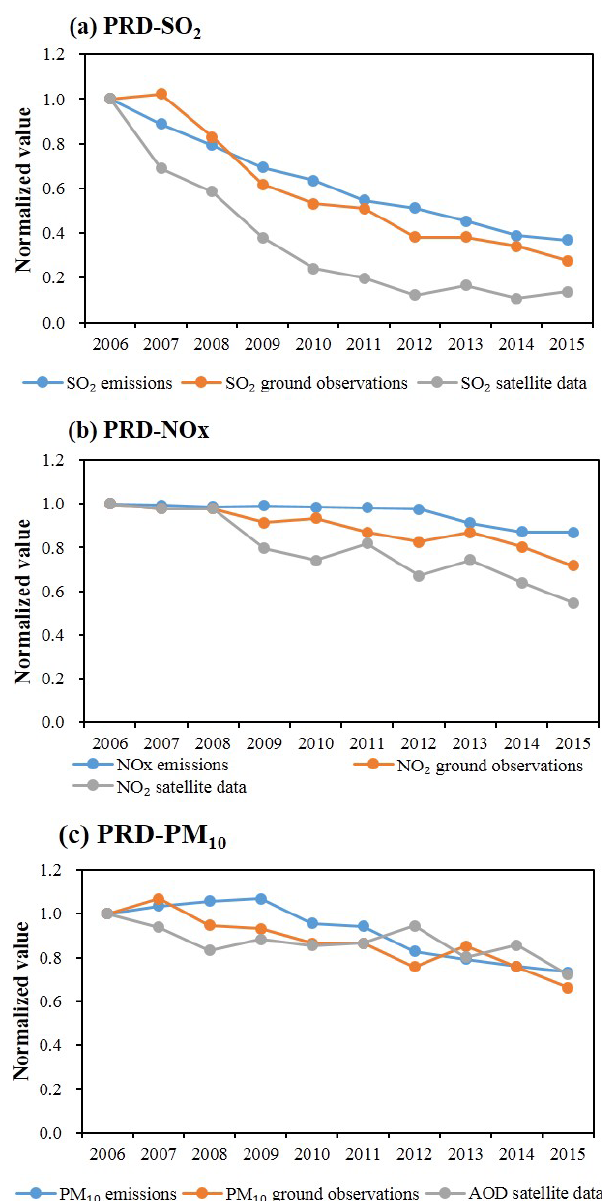
Figure 2. Comparison of emission trends of (a) SO 2 , (b) NO x , and (c) PM 10 with ground-level/satellite measurements in PRD from 2006 to 2015. (All data are normalized to the year 2006.)